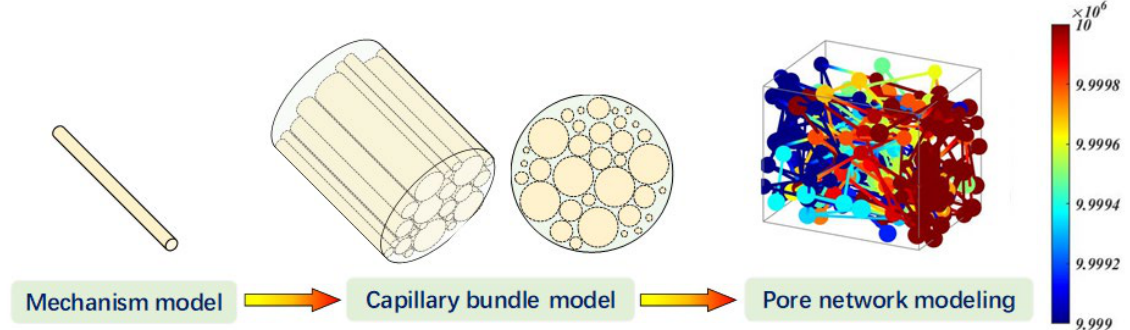
Figure 1. Mimicking methane flow behavior with different approaches.